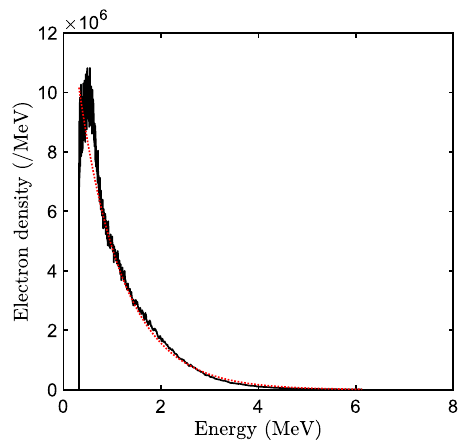
FIG. 2. Measured electron spectrum (black solid line) and Maxwellian fit (dashed red line) after the interaction of the TARANIS laser (details in the text) with a 50 μ m gold target. The Maxwellian fit corresponds to an electron temperature of 0.9